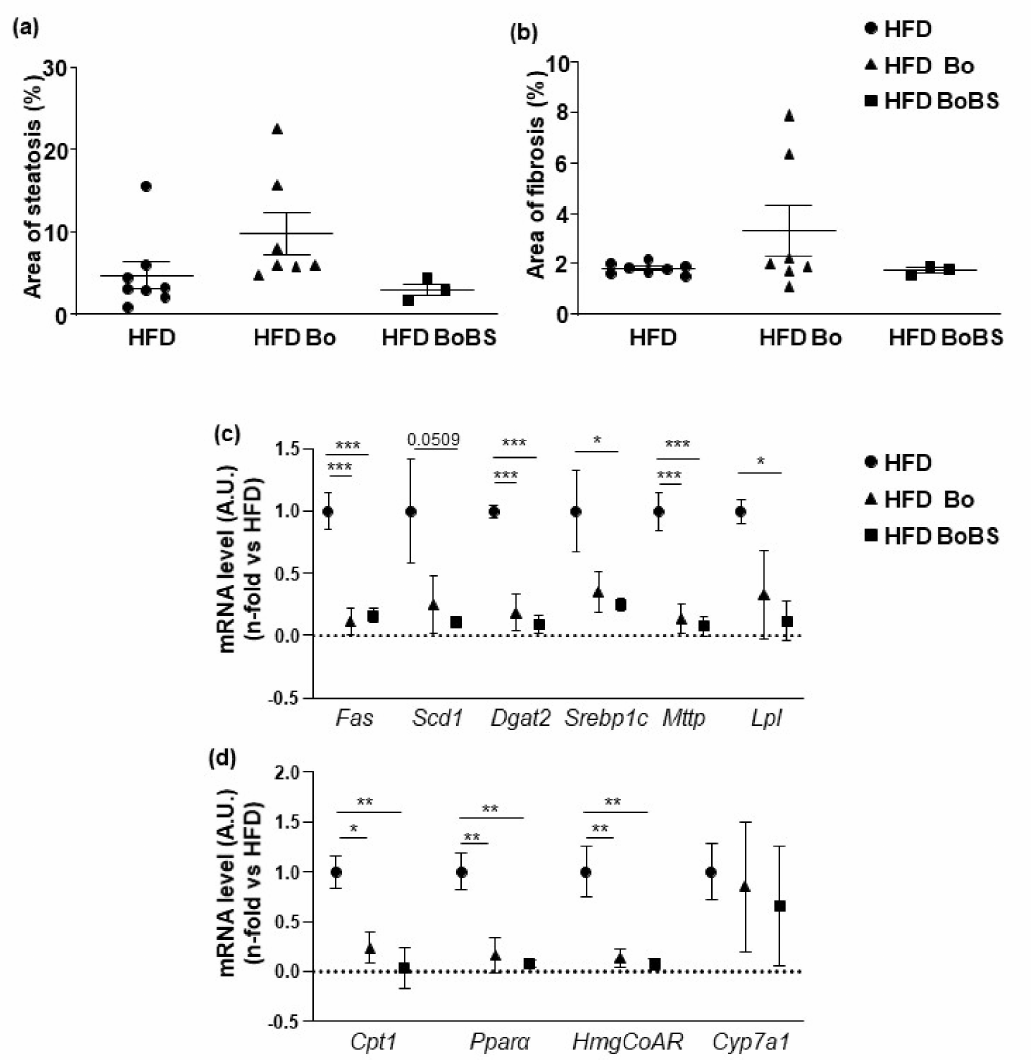
Figure 4. Effect of carrot supplementation on liver steatosis ( a ) and fibrosis ( b ) in ApoE − / − mice fed with HFD (black circle, n = 8; samples from 4 males and 4 females), or HFD containing Bolero (black triangle and black square for HFD supplemented with Bolero under standard condition (Bo; n = 7; samples from 5 males and 2 females) or under biotic stress condition (BoBS; n = 3; samples from 3 males). ( c ) Relative gene expression of hepatic lipogenic enzyme ( Fas ; Scd1 ; Dgat2 ; Srebp1c ; Mttp ; and Lpl ) (for HFD group n = 5, samples from 5 males; for HFD Bo group n = 6, samples from 6 males; for HFD BS group n = 6, samples from 6 males). ( d ) Relative hepatic gene expression of Cpt1 ; Ppar α , HmgCoAR , and Cyp7a1 . Data were given as mean ± SEM. * p < 0.05, ** p < 0.01, *** p < 0.001 vs., HFD